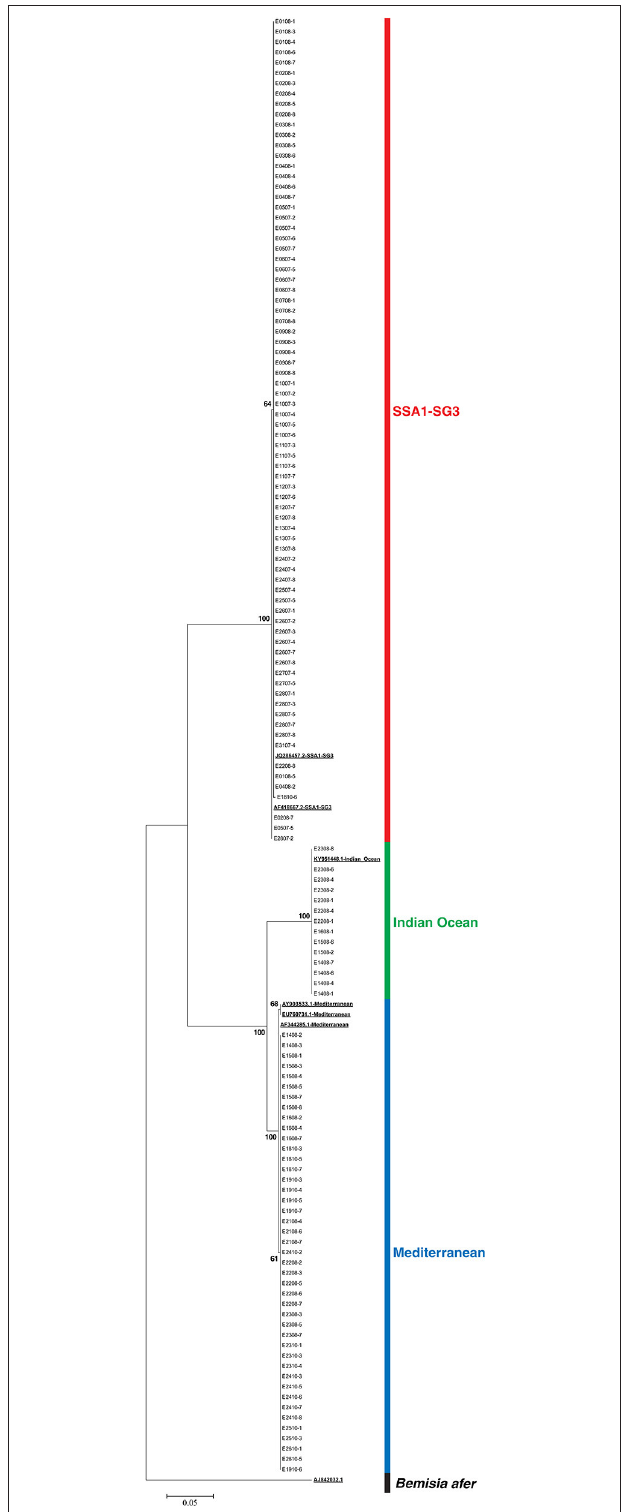
FIGURE 1 | Maximum likelihood phylogenetic tree of EPG recorded Bemisia tabaci whiteflies, reference sequences (underlined and bold), and Bemisia afer sequence as an